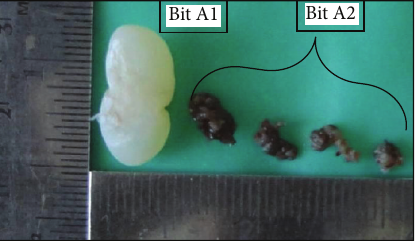
Figure 3: Gross specimen photograph of the incisional